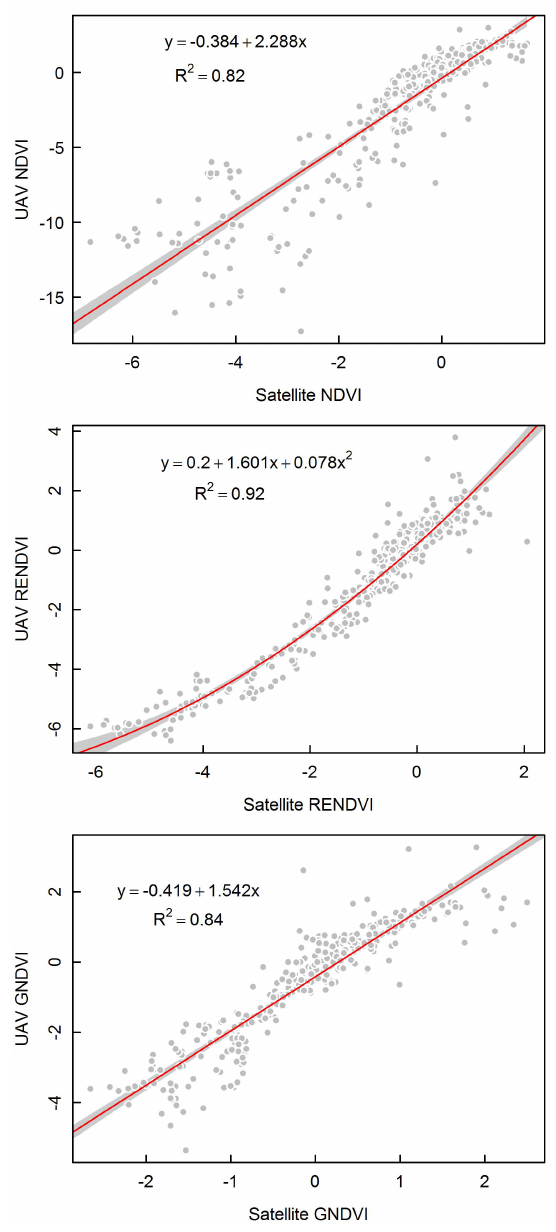
Figure 6. The relationship between UAV and satellite-derived vegetation indices. Each datum represents the mean results extracted from a single time step for a tree cluster and the shaded area shows the confidence